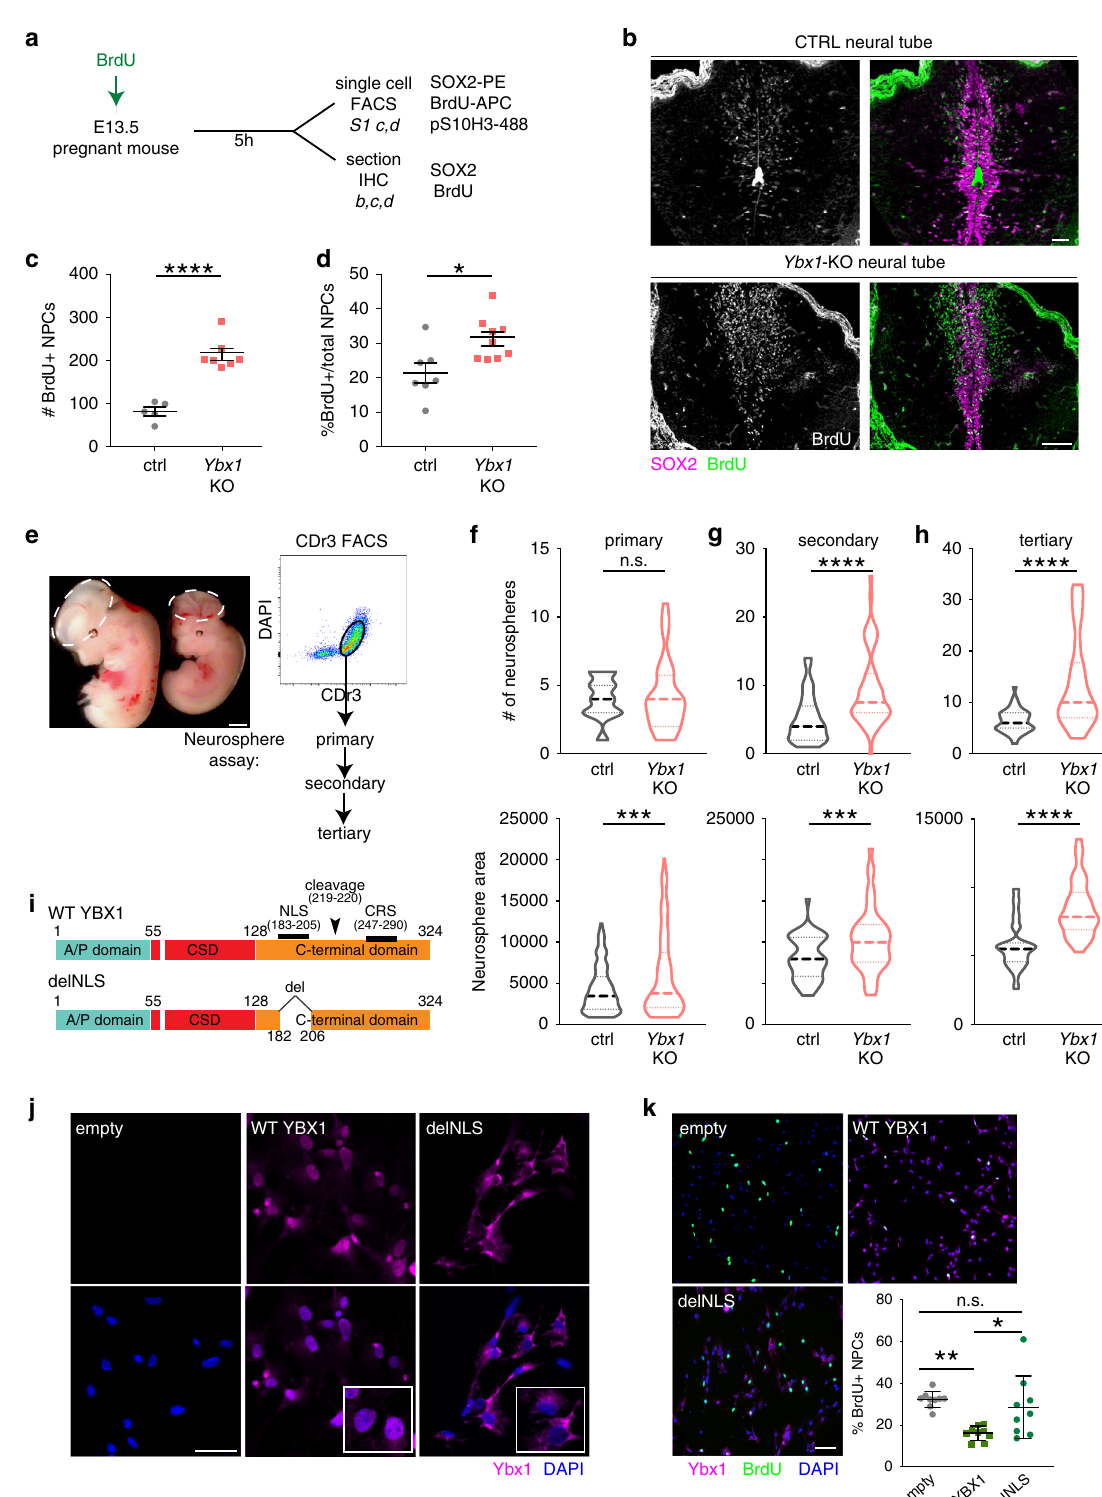
performed RNA-sequencing (RNA-seq) of Sox2-positive NPCs sorted from E13.5 Ybx1 -KO and sibling controls (Supplementary Fig. S3a). We analyzed expressed genes as those having FPKM values > 1 in either control or Ybx1 -KO NPCs. Using the criteria of adjusted P < 0.05 and fold-change > 1.5 to compare